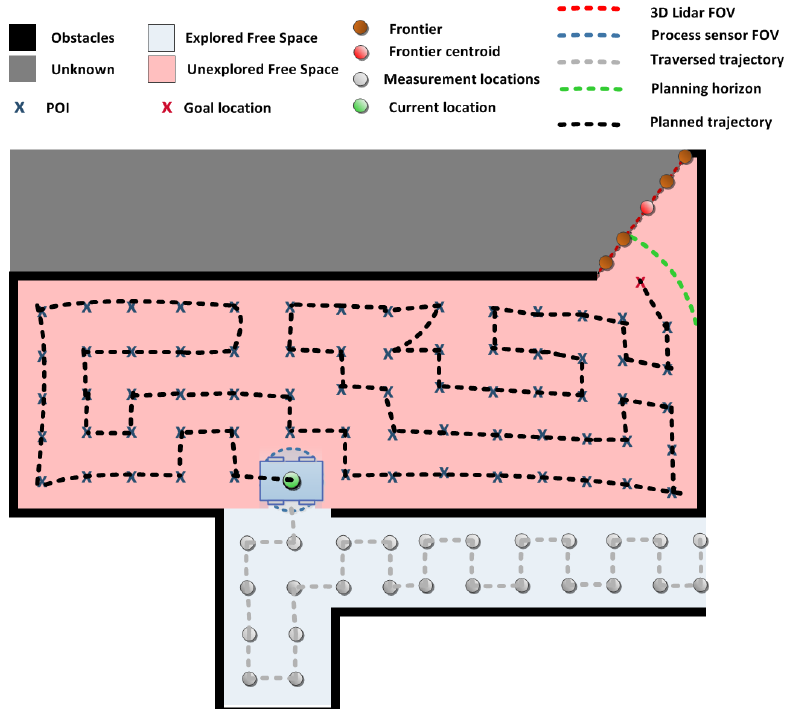
Figure 5. All components of a single multi-step of our integrated exploration strategy: Grey circles represent previously obtained measurements and the area around those circles is considered explored (light blue). Robot, at the current location (green circle), samples Point of Interest (POI, blue crosses)—in the obstacle-free region of the map, where the process is unexplored (red area)—within radius r (green line). The routing algorithm provides a multi-step exploration solution (black dotted line) from the current location to the goal location (red cross). The goal location is the POI closest to the frontier (brown circles) and the corresponding centroid (red circle). The frontier is defined by the LIDAR FOV (red dotted line). Obstacles are marked by a black line and unexplored area in